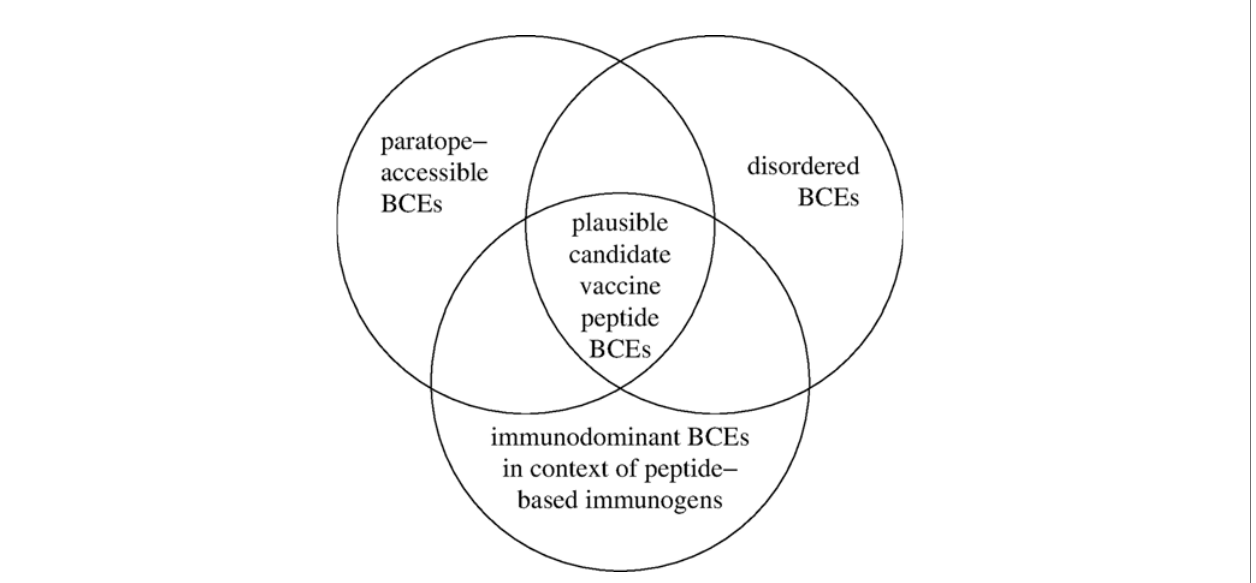
FIGURE 1 | Identi fi cation of plausible candidate vaccine peptide BCEs. Accessible disorder (AD) is realized for BCEs that are simultaneously both paratope- accessible and disordered (i.e., conformationally unconstrained) in both peptide-based immunogens and cognate native antigenic targets in situ (e.g., extracellular pathogen virulence factors). Immunodominant BCEs are identi fi ed empirically as they occur in peptide-based immunogens (e.g., using immunogenic carrier molecules and immunologic adjuvants) versus other contexts (e.g., in native antigenic targets comprising antigenic